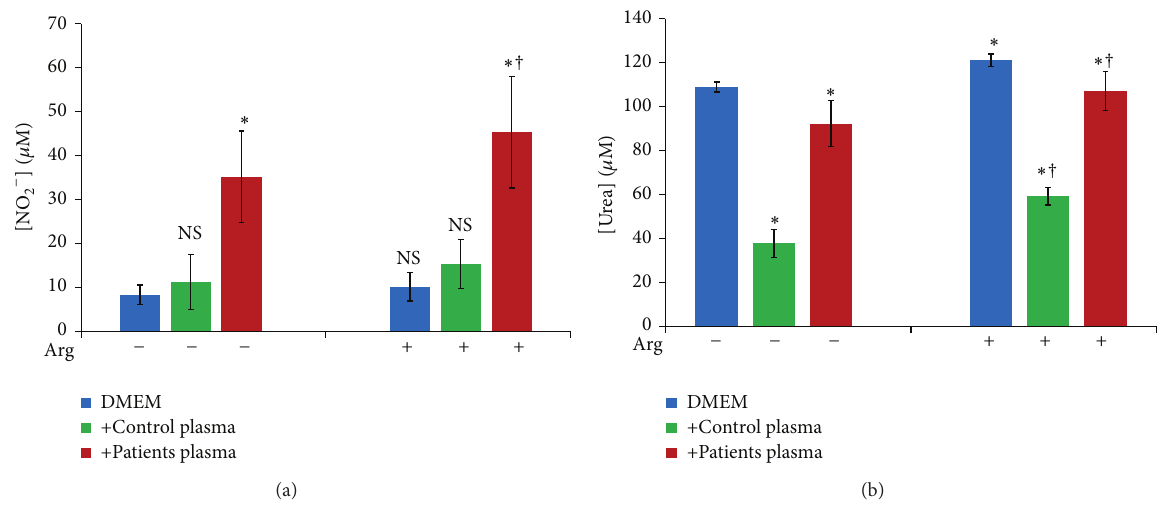
Figure 7: Effect of plasma addition on NO (a) and urea (b) production by patients’ PBMC cultures ( 𝑛 = 26 ) in DMEM with or without L-arginine at 1mM (CM: medium without plasma, ns: 𝑃 > 0.05 , ∗ : 𝑃 < 0.05 versus CM, and † : 𝑃 < 0.05 versus culture without L-arginine).